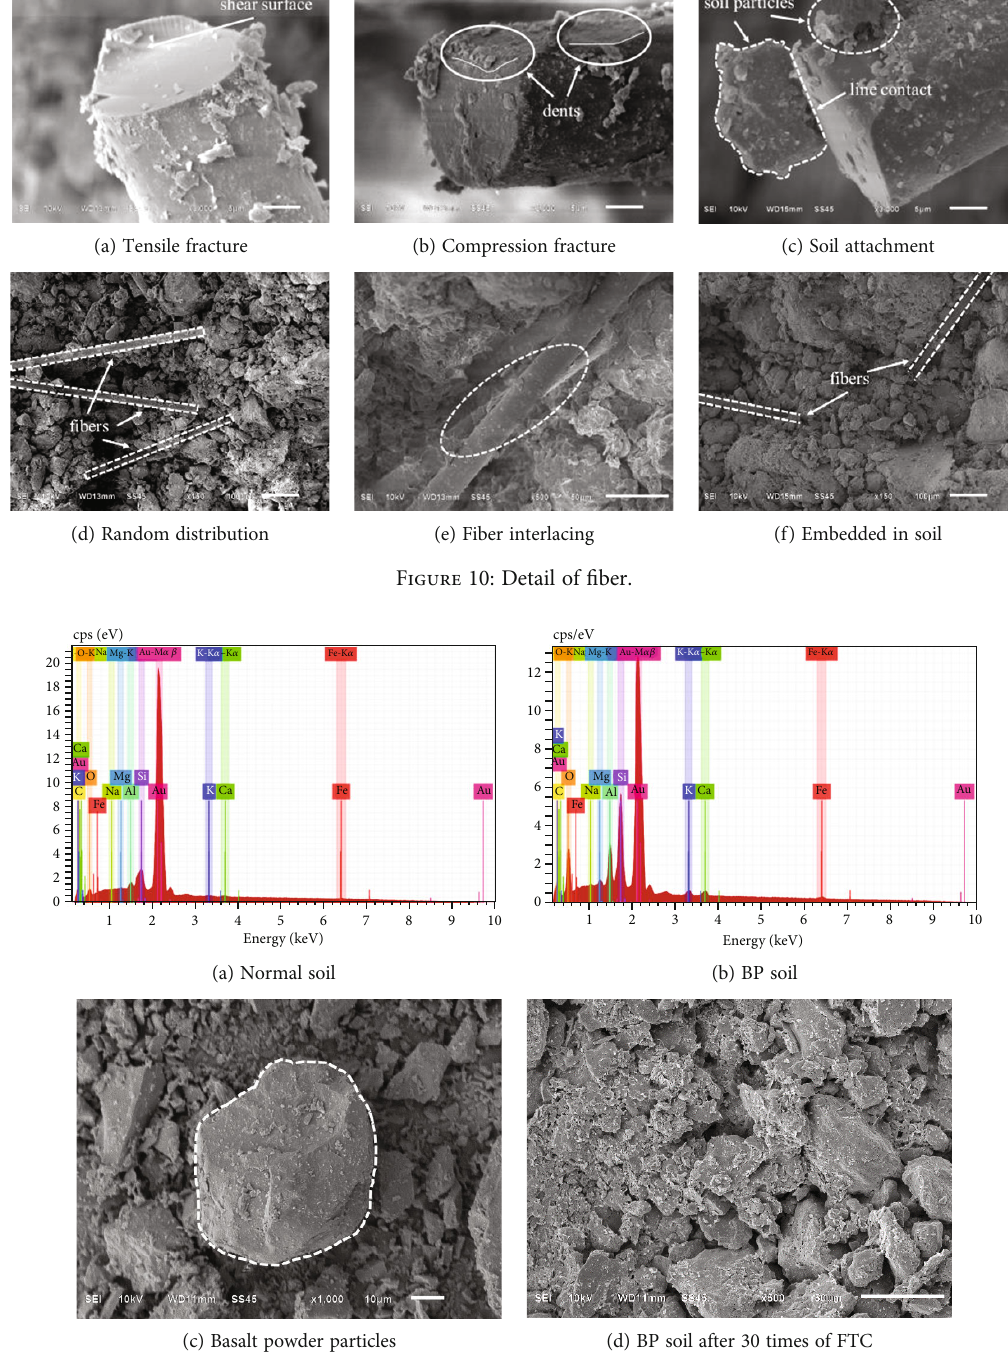
Figure 11: SEM and EDS